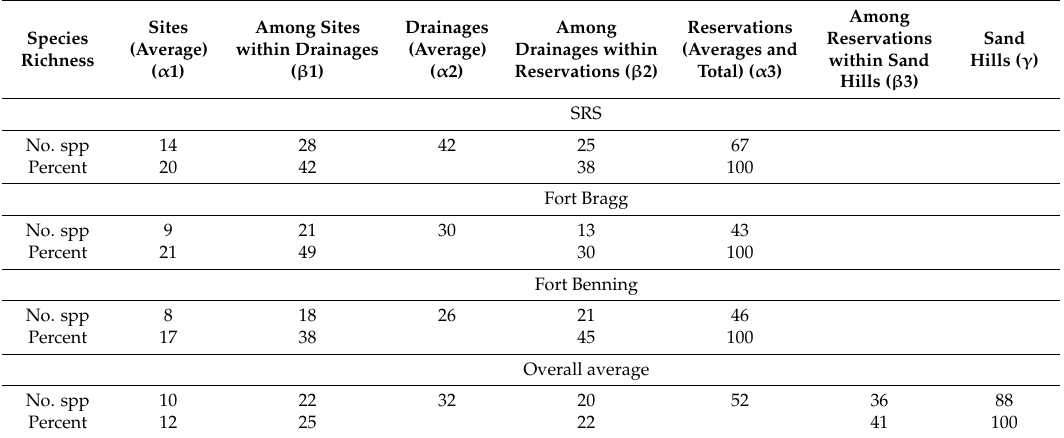
Table 4. Additive diversity partitioning of fish species richness in Sand Hill streams showing diversity components associated with progressively larger spatial